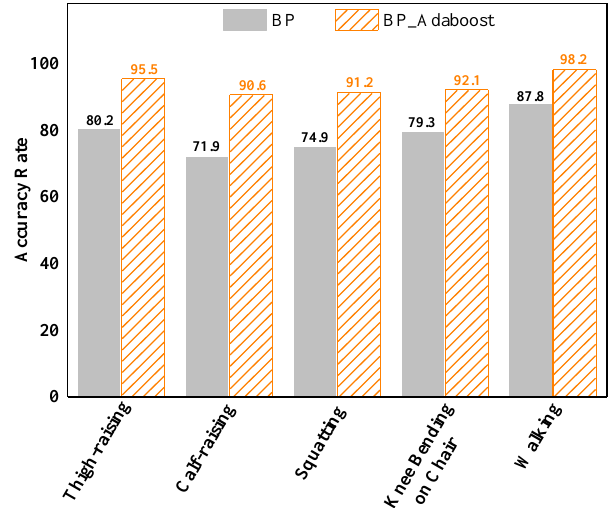
Figure 9. Comparison of BP and BP_AdaBoost algorithms.